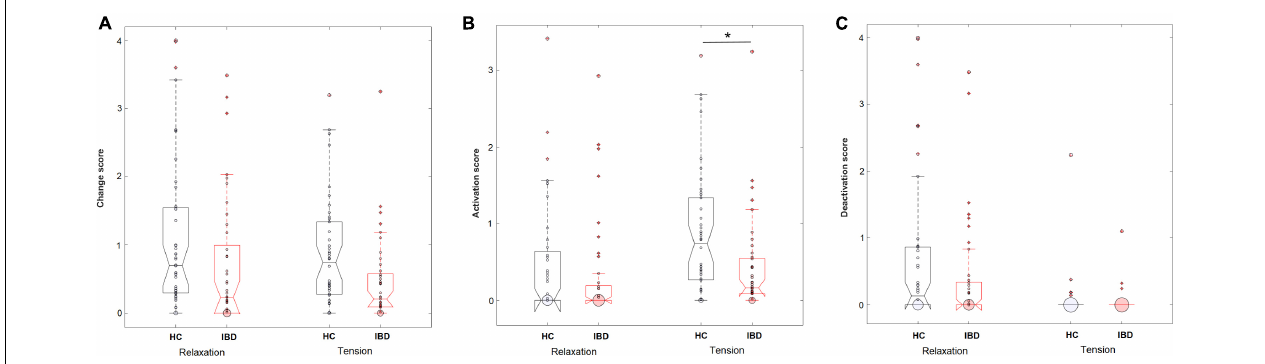
FIGURE 3 | Perceived levels of overall changes in the body (A) , sensations of activation (B) , and sensations of deactivation (C) in the body during the experience of relaxation and tension in HC ( n = 44) and IBD ( n = 41). * p <